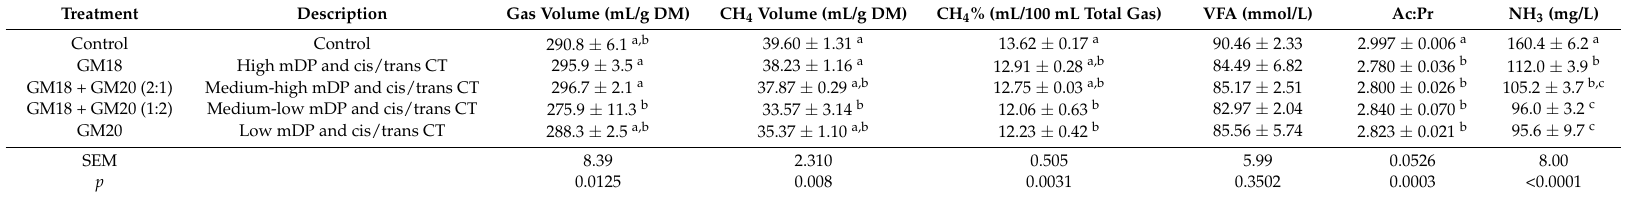
Table 3. In vitro fermentation parameters for Experiment 2; gradient of grape marc samples with differing tannin composition.